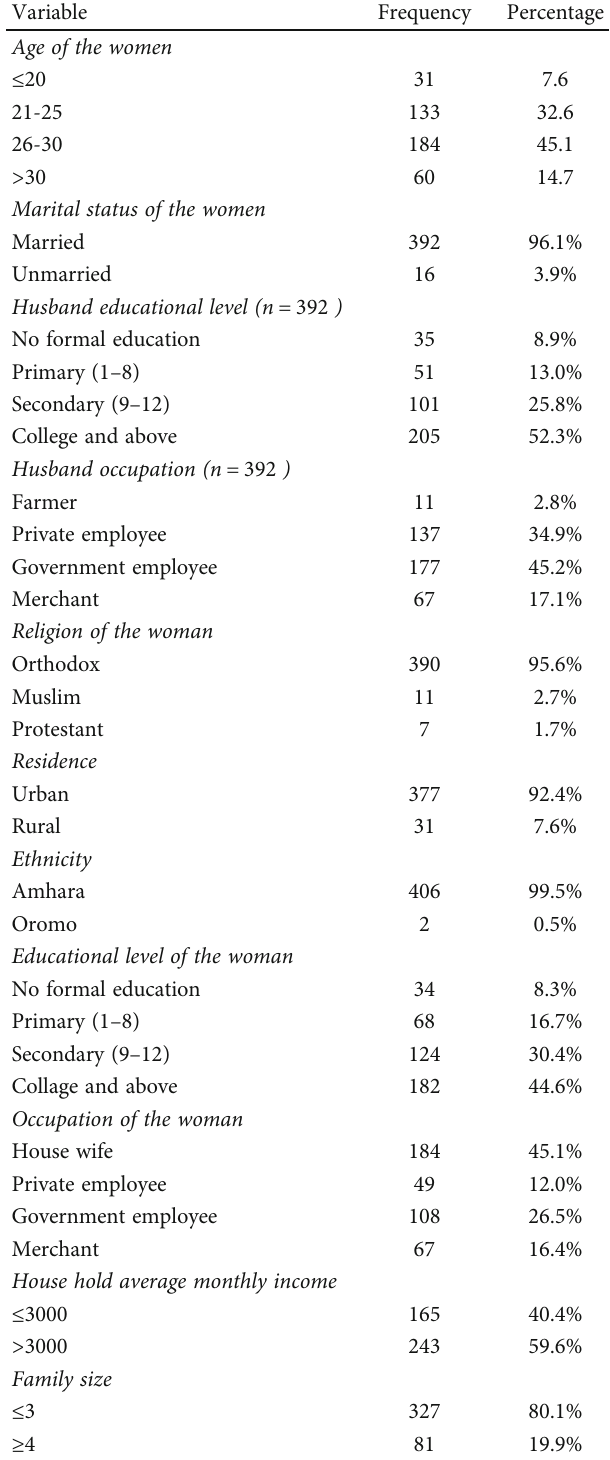
Table 1: Sociodemographic characteristics of women attending antenatal care at Debre Markos town public health institutions, Northwest Ethiopia, 2021 ( n = 408